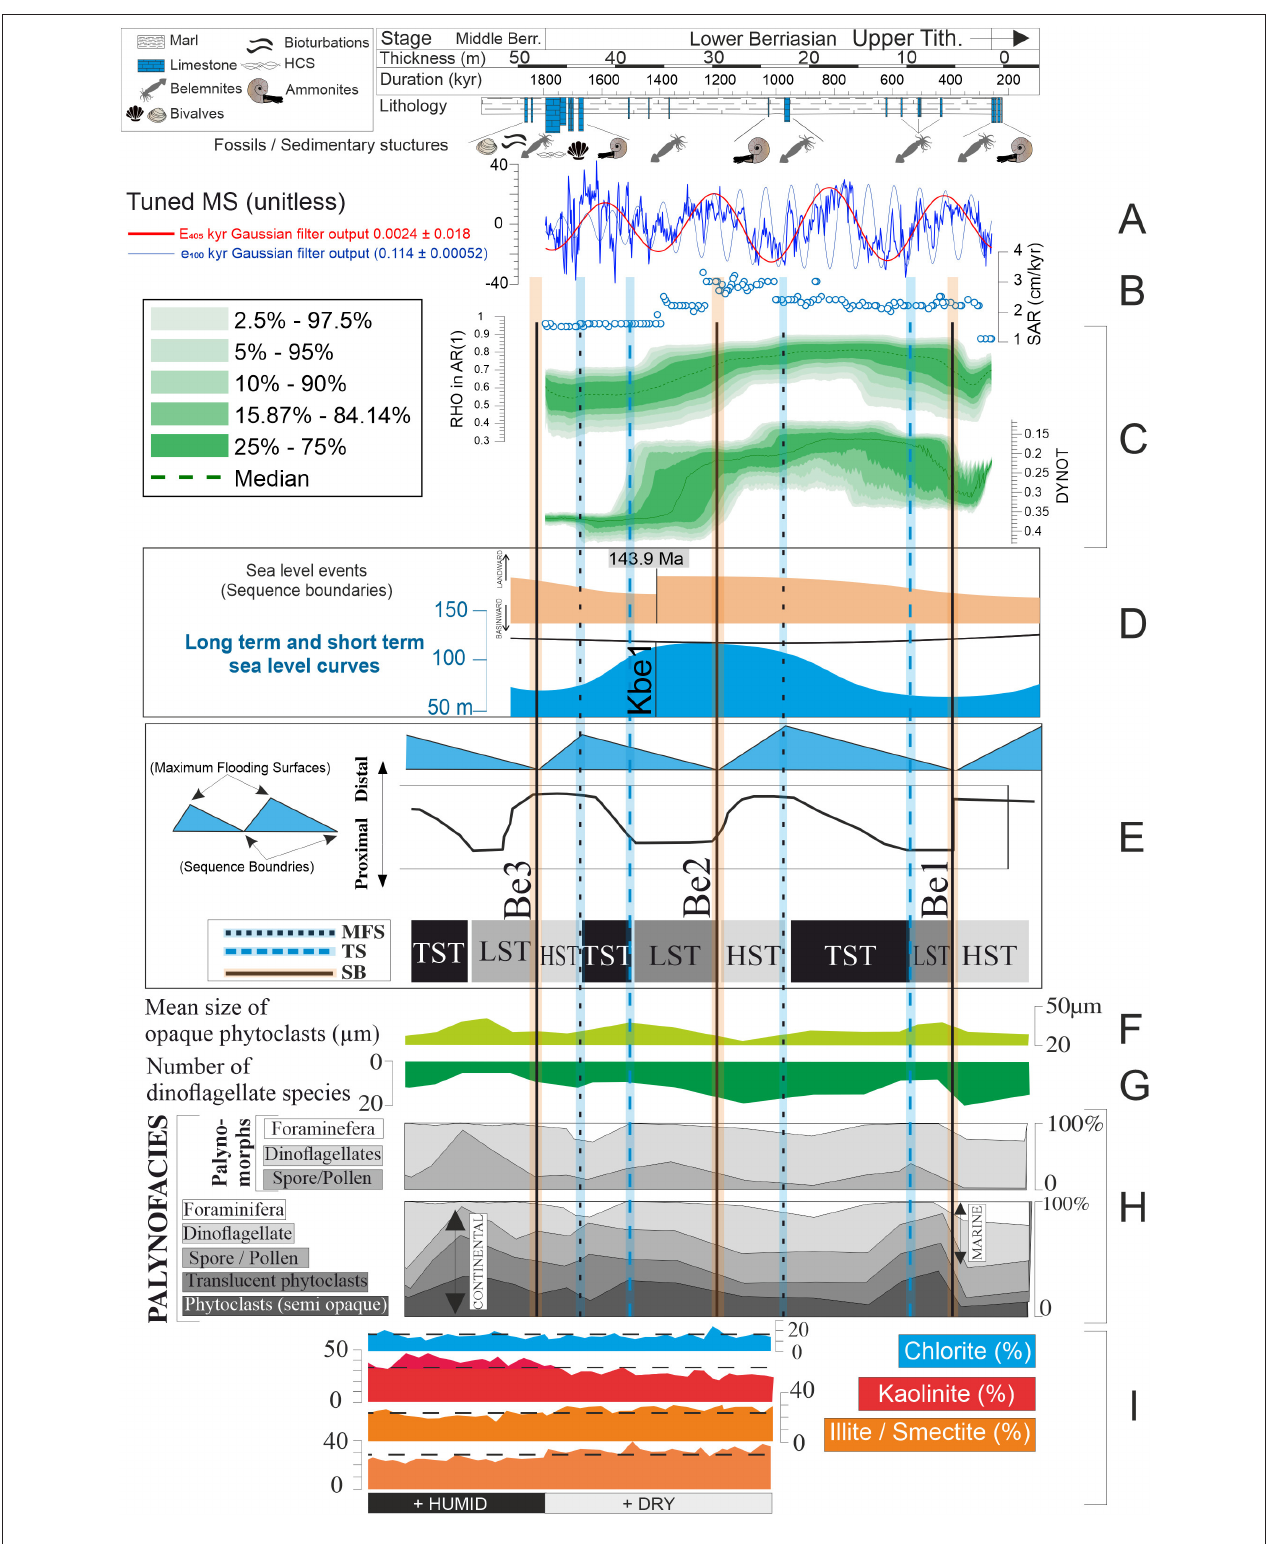
FIGURE 10 | Sequence stratigraphy and paleoclimate change during the Early Berriasian in central Tunisia. Time scale and biostratigraphy are from our ATS (current study) and M’Rabet (1981, 1987), respectively. (A) MS series and filtered long- and short eccentricity cycles. (B) Tracked highest eCOCO × SL (Results), (C) DYNOT and ρ 1 models of the MS series. The DYNOT and ρ 1 were estimated using a running window of 400, 5 kyr step and a sample rate between 2.26 and 3.18 kyr.